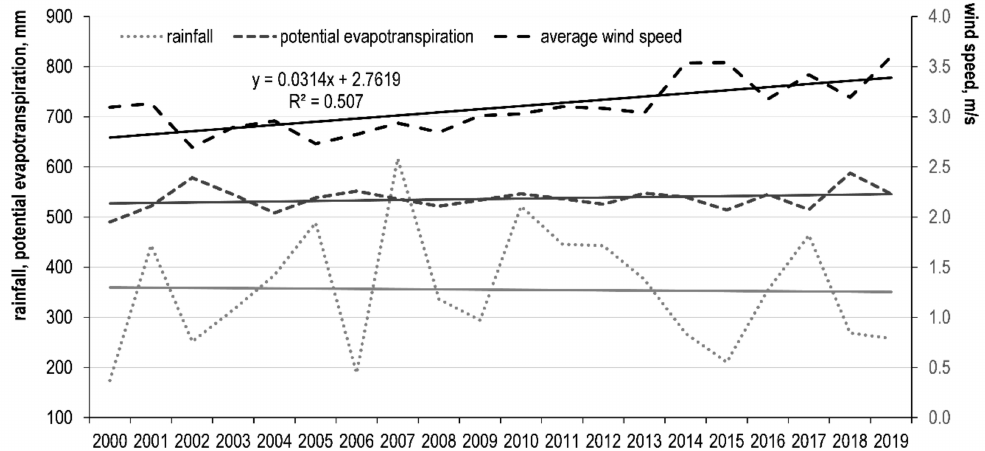
Figure 4. Trends and variation of meteorological parameters average values during the growing season (May–September).